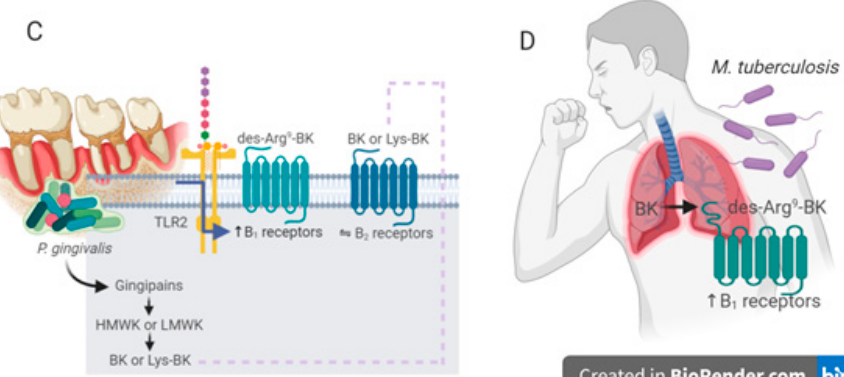
Figure 1. Relevance of components of the kinin system in bacterial infections. ( A ) E. coli LPS is a classical stimulus for kinin B 1 receptor induction in vascular tissues, likely contributing to hypotension in systemic inflammation. E. coli LPS-induced B 1 receptor upregulation rely on TLR4 activation and de novo protein synthesis, mediated by the transcriptional factor NF- κ B. Part of the hypotensive e ff ects of LPS are related to an increased production of BK and B 2 receptor activation. ( B ) Streptococcal respiratory infections caused by S. pyogenes trigger the activation of contact system, via modulation of FXII, PPK and kallikrein. Plasmin activation by S. pyogenes streptokinase increases BK levels. Upon the bacteria spread throughout the blood stream due to increased vascular permeability, the patient develops systemic inflammatory response syndrome (SIRS) with coagulopathy and hypotension, causing multiple organ failure and shock. The modulation of one or more components of kinin formation pathways might be useful for management of septic patients. ( C ) P. gingivalis- produced gingipains cleave kininogen precursors, leading to BK and Lys-BK formation in periodontal tissues. Part of tissue destruction is mediated by the activation of constitutive B 2 receptors. P. gingivalis LPS activates TLR2 and induces an upregulation of B 1 receptors, which might sustain the chronic inflammation in periodontal disease. ( D ) M. tubercul osis infection is able to upregulate kinin B 1 receptors in lungs, with an